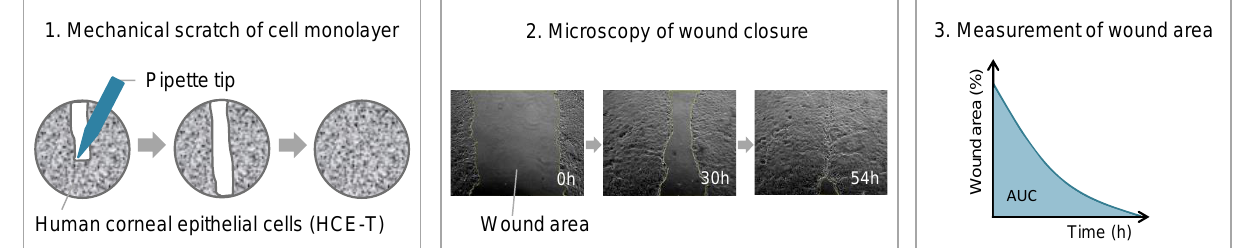
Figure 12. Procedure of the DED wound healing model.